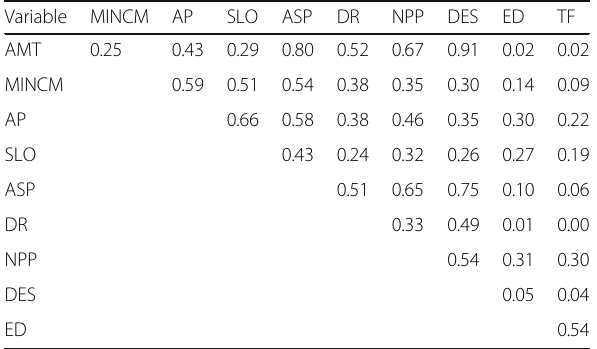
Table 1 Correlation indices among the variables included in the modeling of the habitat suitability of